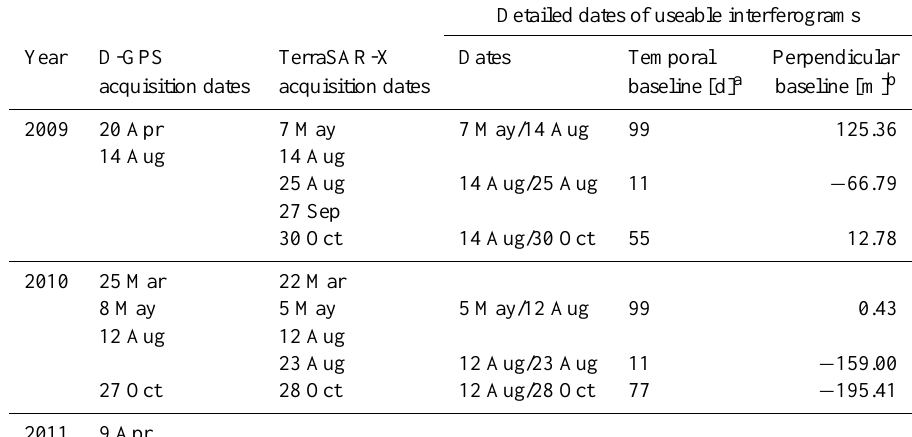
Table 1. Acquisition dates for the d-GPS and TerraSAR-X data and details of the useable differential interferograms considered in this study.